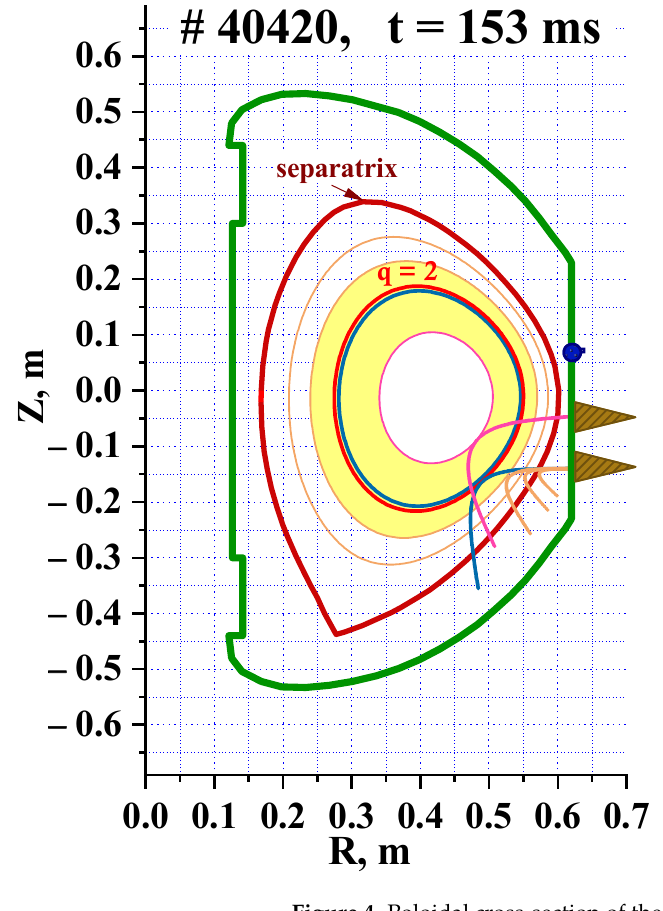
Figure 4. Poloidal cross-section of the Globus-M2 tokamak with magnetic field lines using EFIT and performed ray tracing for DBS probing waves for discharge #40420.